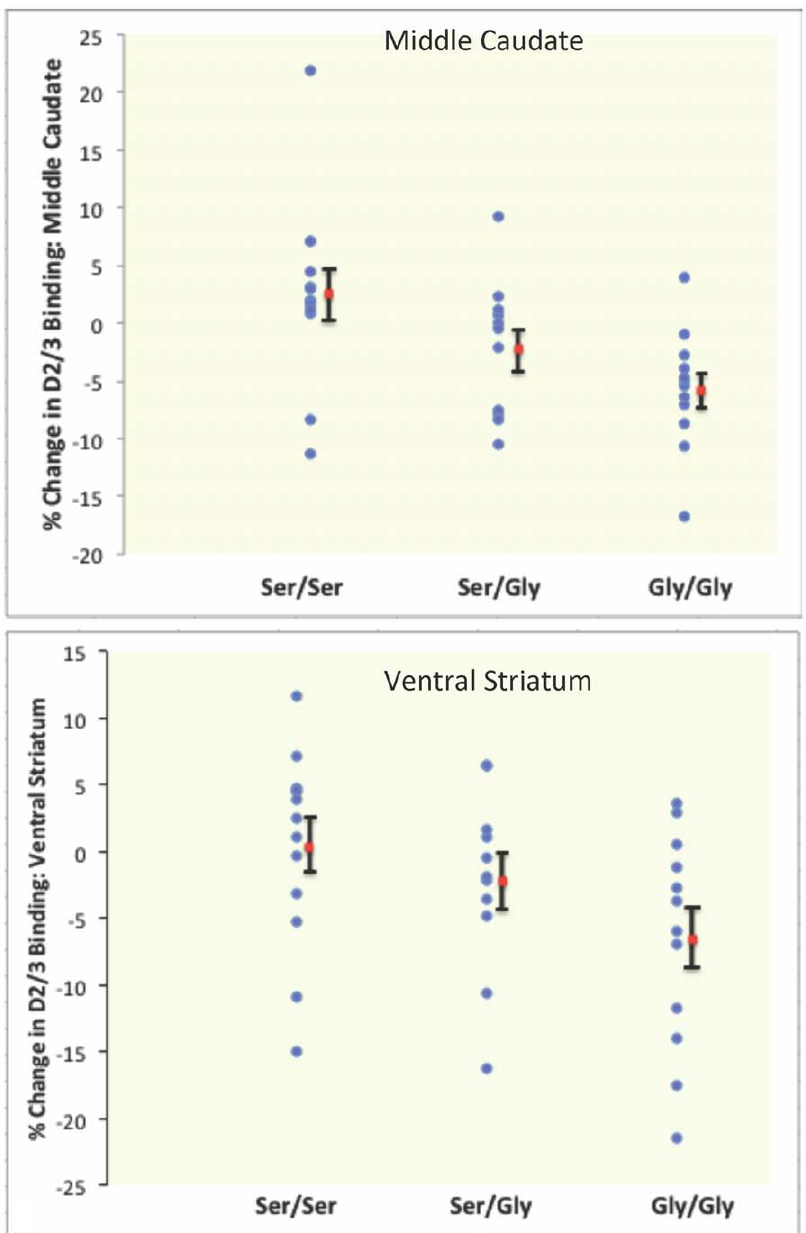
Figure 2. Scatterplots of the percent change in D2/D3 receptor binding in the reward versus baseline condition for the middle caudate and the ventral striatum. The mean change in D2/D3 receptor binding for each group is represented by the red square and the standard error of the mean is shown with the error bars. Negative values are indicative of greater dopamine release in the reward versus baseline condition.